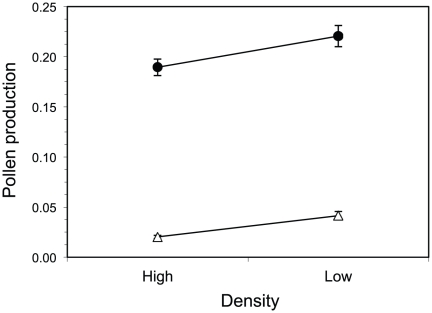
Differences in the proportion of above-ground biomass allocated to pollen between males (πm - circles) and hermaphrodites (πh - triangles) in high and low density treatments.Error bars represent one standard error.